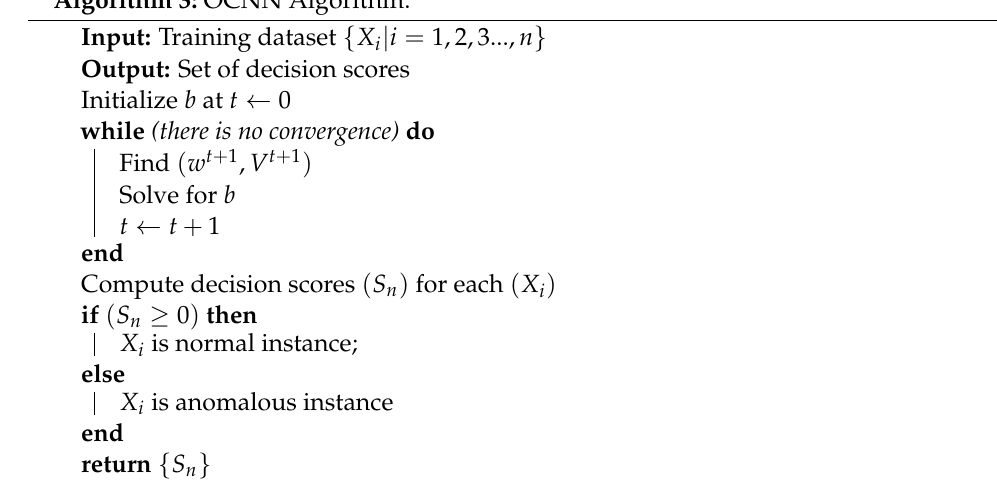
Algorithm 3: OCNN Algorithm.